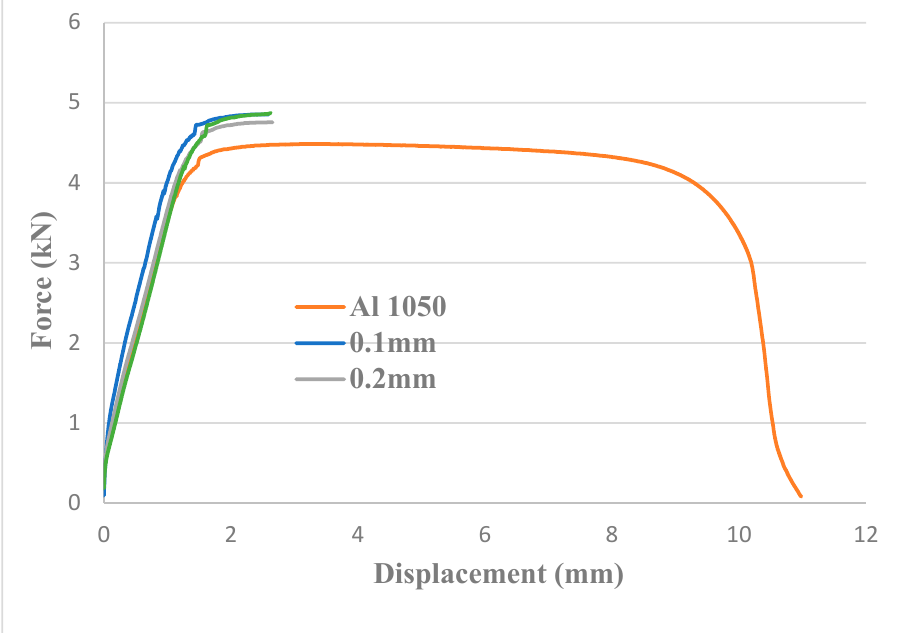
Figure 16. Comparative tensile test for foils of different thicknesses. Table 2. Comparative tensile test results before and after corrosion testing.